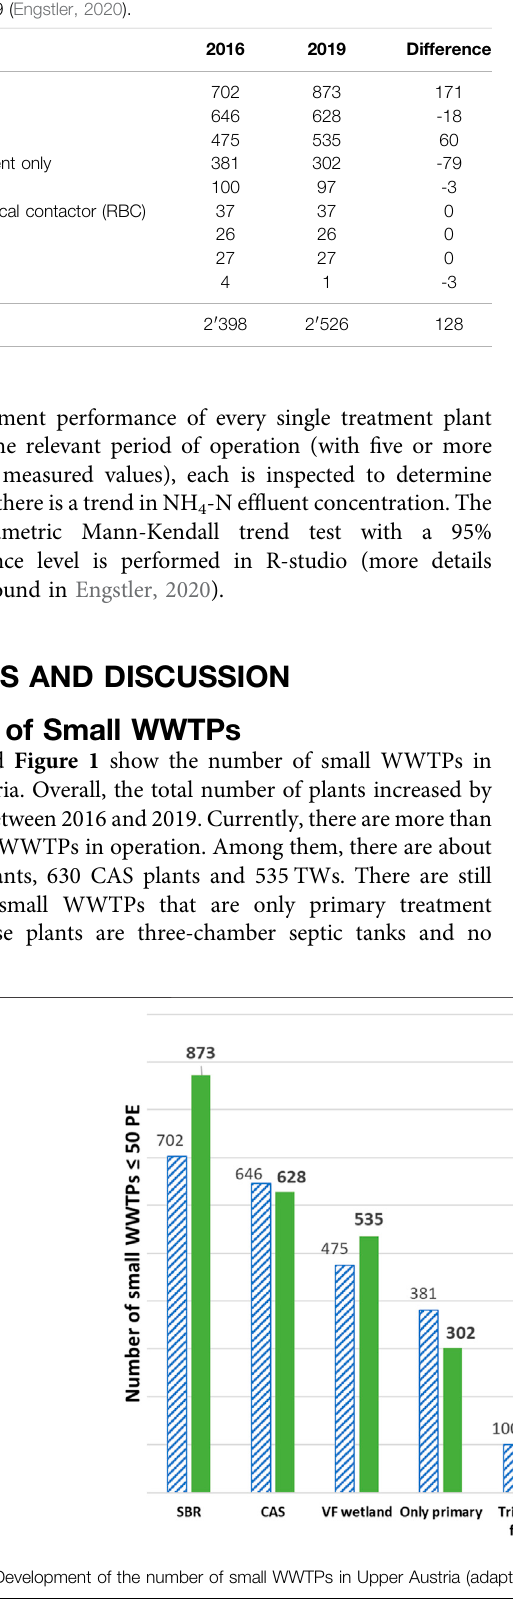
Frontiers in Environmental Science |